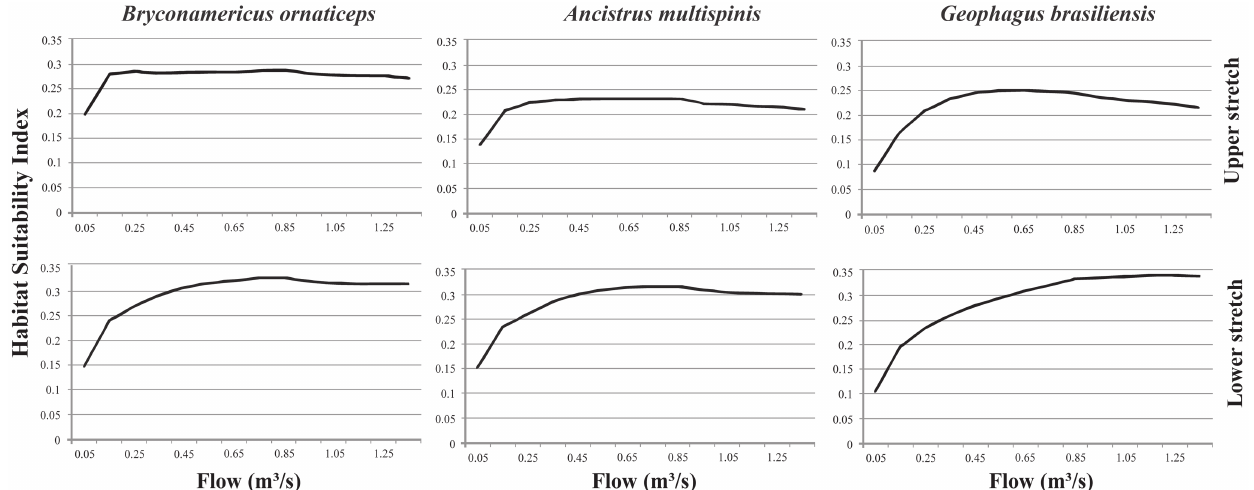
Fig. 5. Average habitat suitability index –HSI– in the upper and lower reach of the riacho São Pedro, for the three fish species.